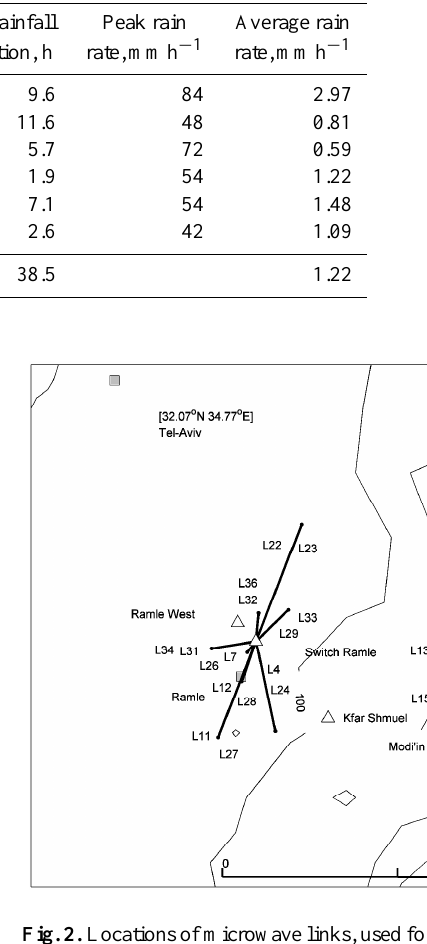
Table 1. List of rainstorms, used for empirical assessment of MSE prediction accuracy.